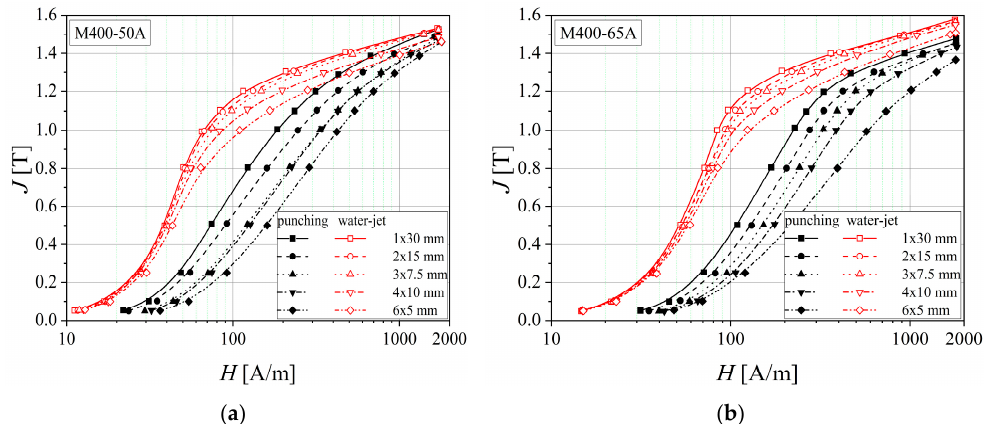
Figure 9. Normal magnetization curves of M400 electrical steel grade, in the case of different sample thickness (0.50 mm ( a ) and 0.65 mm ( b )) and two cutting technologies.